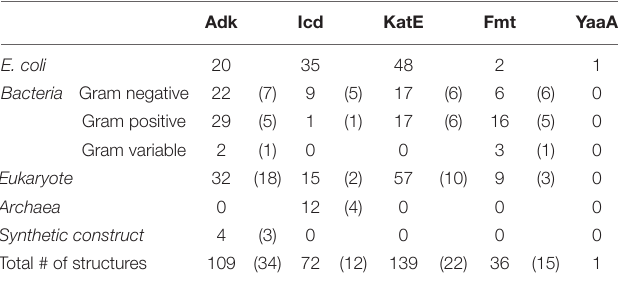
Structures are grouped by domain of life and numbers in parentheses indicate the number of unique organisms represented in each set. E. coli proteins are not included in the Gram-negative protein